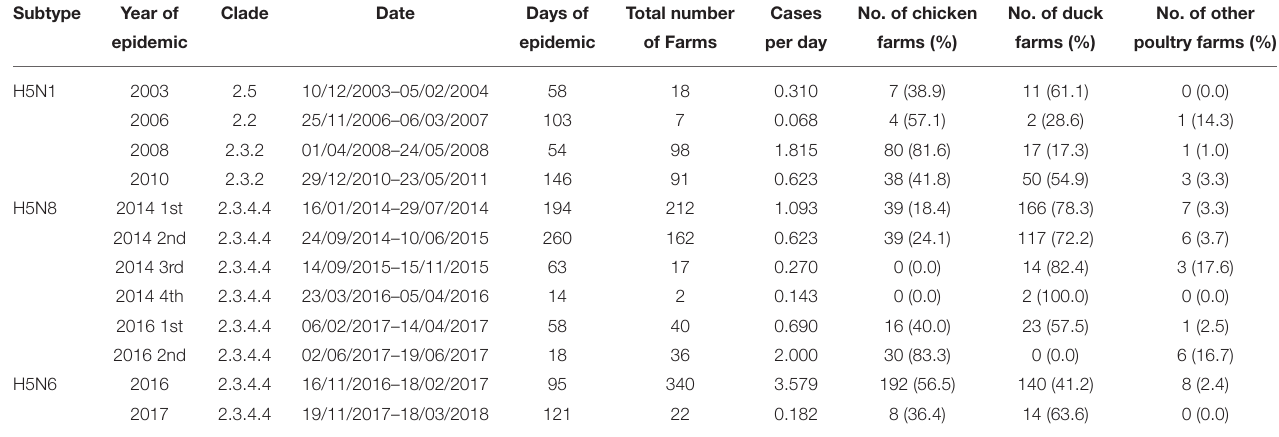
TABLE 1 | HPAI epidemic in Korea from 2003 to 2018. Subtype